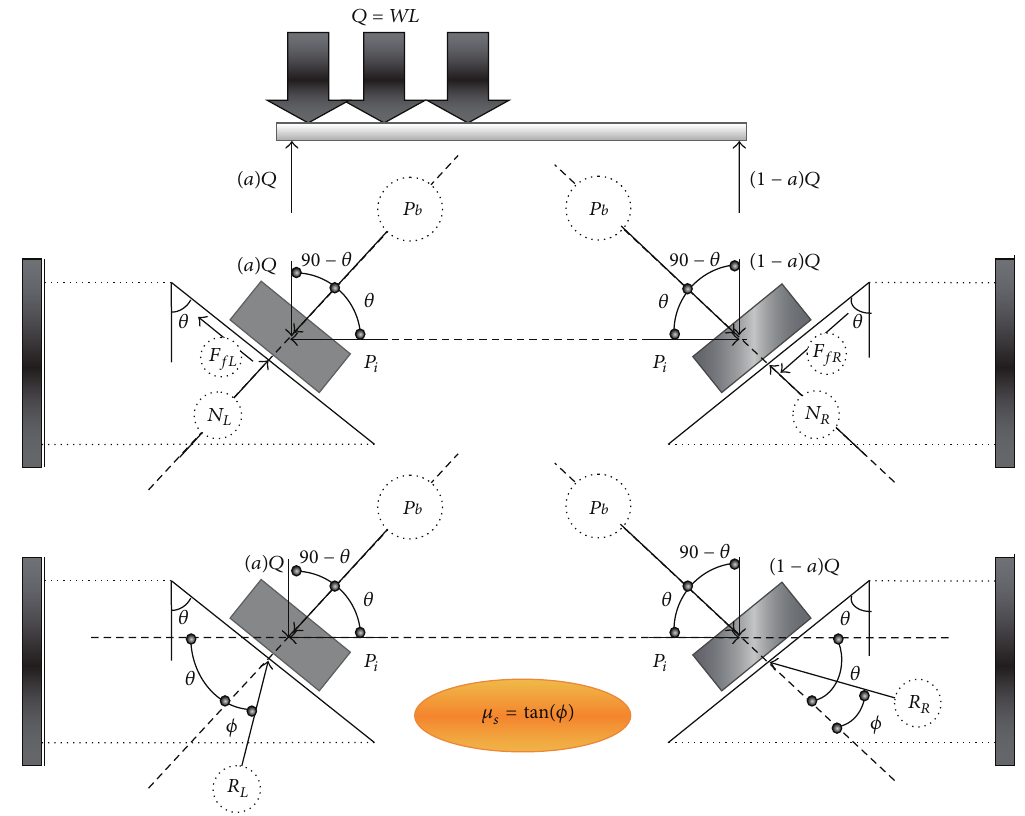
Figure 11: Free body diagram of beam with nonsymmetric gravity load before thermal effect (friction bolted support). 𝑃 = (𝑎𝑊𝐿) cot (𝜃 + 𝜙) − (𝑃 𝜙/ sin (𝜃 + 𝜙)) ≤ (1 − 𝑖 𝑏 sin 𝜙/ sin (𝜃 − 𝜙)) 𝑎)𝑊𝐿 cot (𝜃 − 𝜙) + (𝑃 𝑏 sin